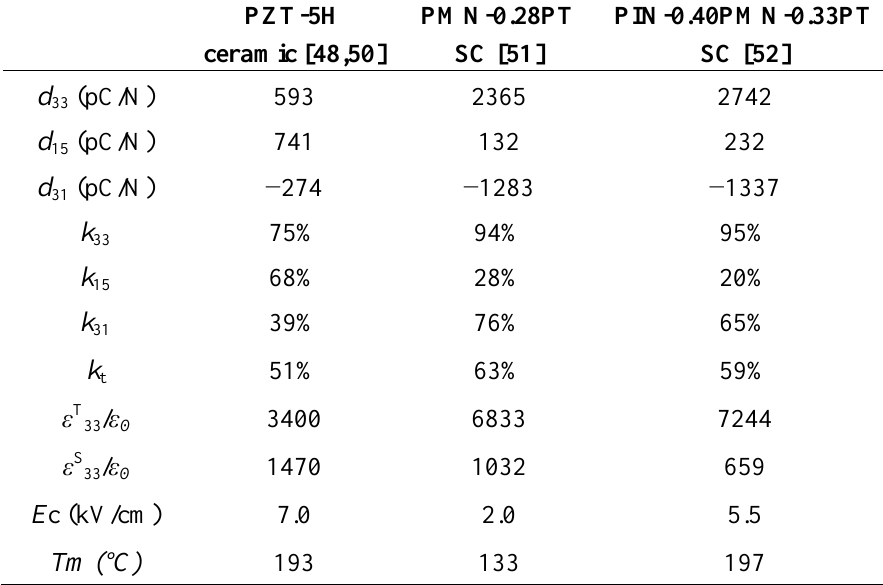
Table 1. Piezoelectric properties of PZT-5H ceramic, [001]-poled PMN-PT and PIN-PMN-PT single